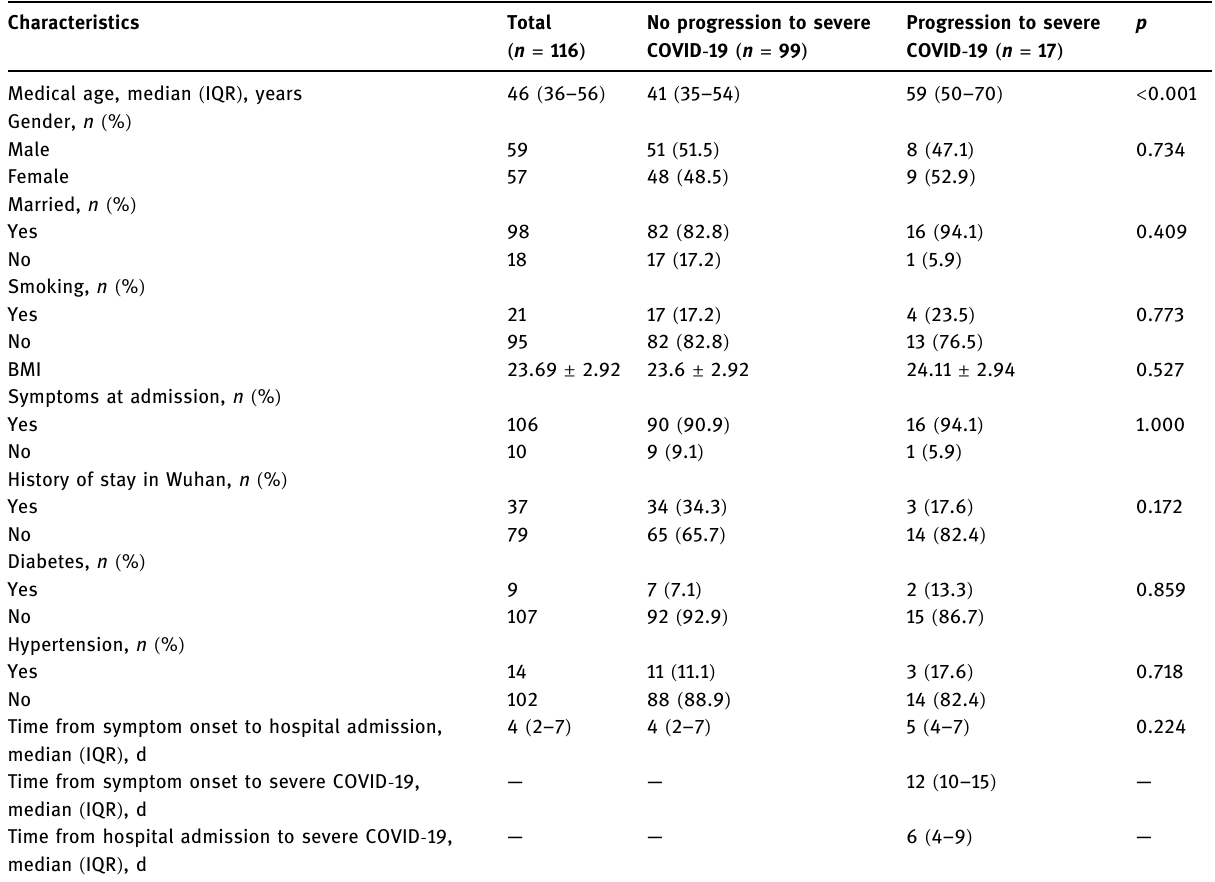
Table 1: Patient characteristics at hospital admission